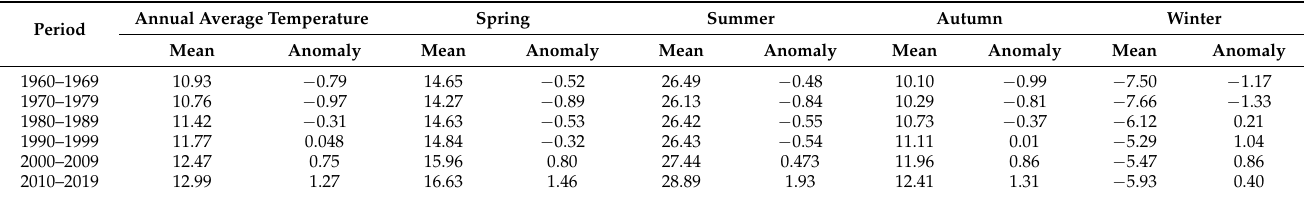
Table 1. Means and anomalies in temperatures across different periods in the Turpan region from 1960 to